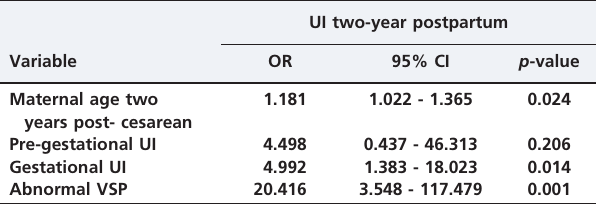
Table 3 - Estimated ß parameter, odds ratio (OR), 95% confidence interval (95% CI) and p-value obtained by adjusting the multivariate logistic model for investigating UI two years after GDM.